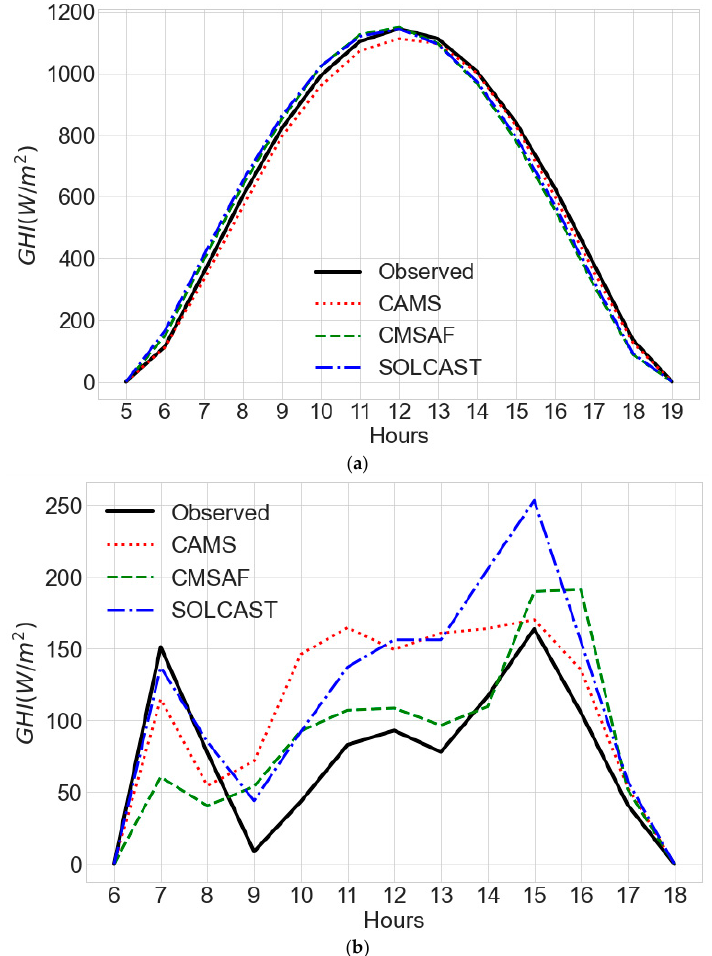
Figure 12. ( a ) The hourly clear sky conditions (cloud information detected by CLAAS-2 satellite- based dataset. ( b ) The hourly overcast sky conditions (cloud information detected by CLAAS-2 sat- ellite-based dataset).